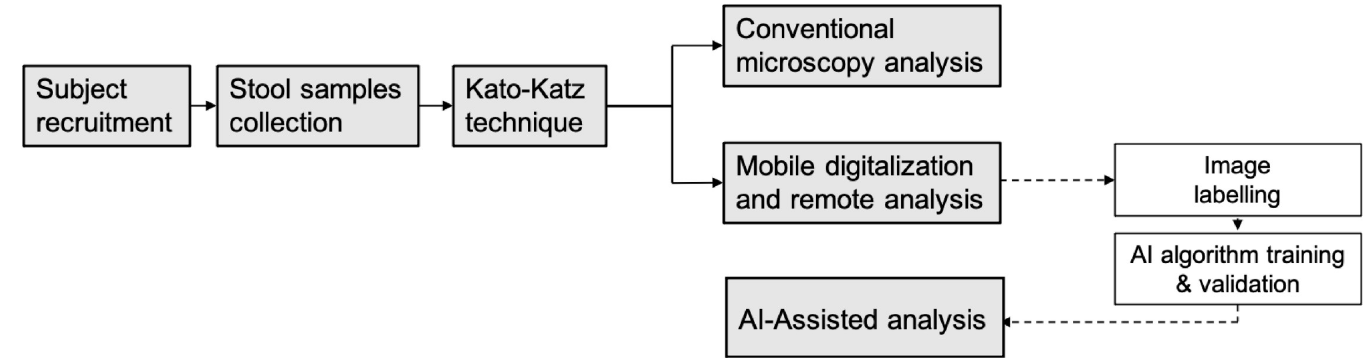
Fig 1. Schematic representation of study design and experimental